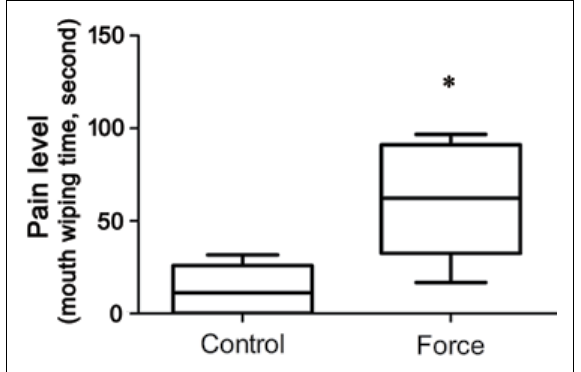
Figure 2. Orofacial pain levels (mouth wiping time, seconds) in saline periodontal group, UFP-101 periodontal group, saline intraperitoneal group and UFP-101 intraperitoneal group. The plus and minus error bars stand for maximal and minimal values, respectively. The box stands for interquartile range and the horizontal line through the box stands for the median value.